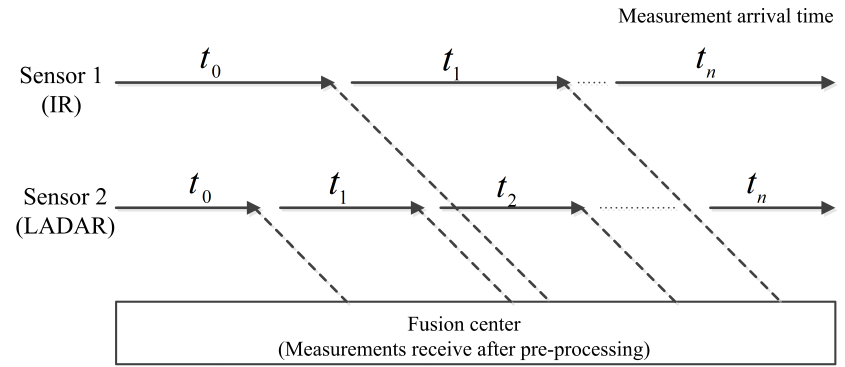
Figure 1. Scenario of out-of-sequence